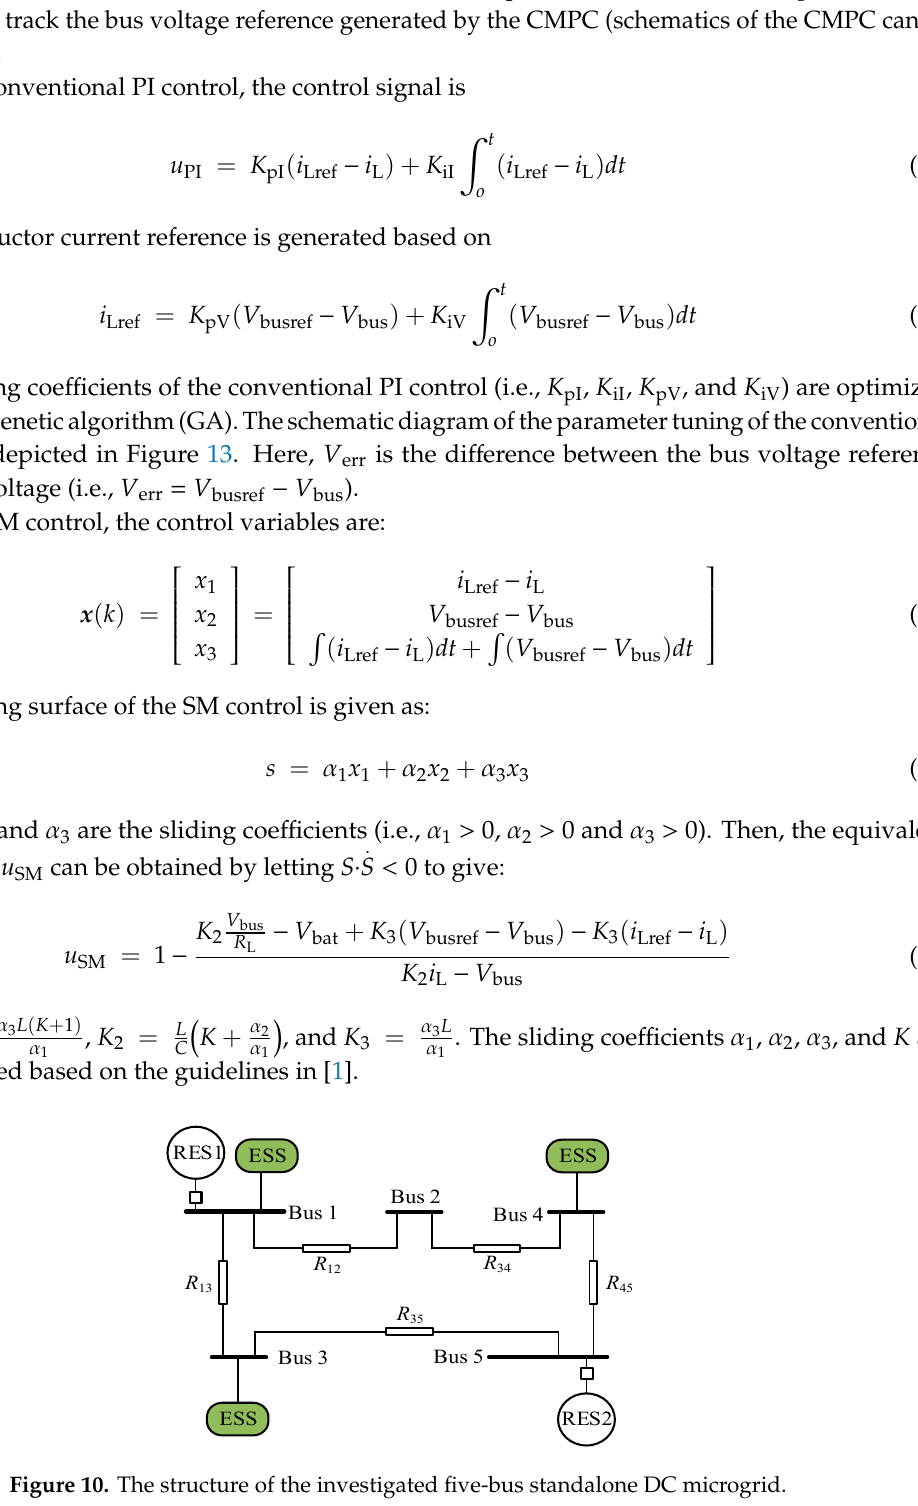
( b ) SM control Figure 11. The circuitry and control of the grid-connected converters for energy storage systems (ESS). CMPC